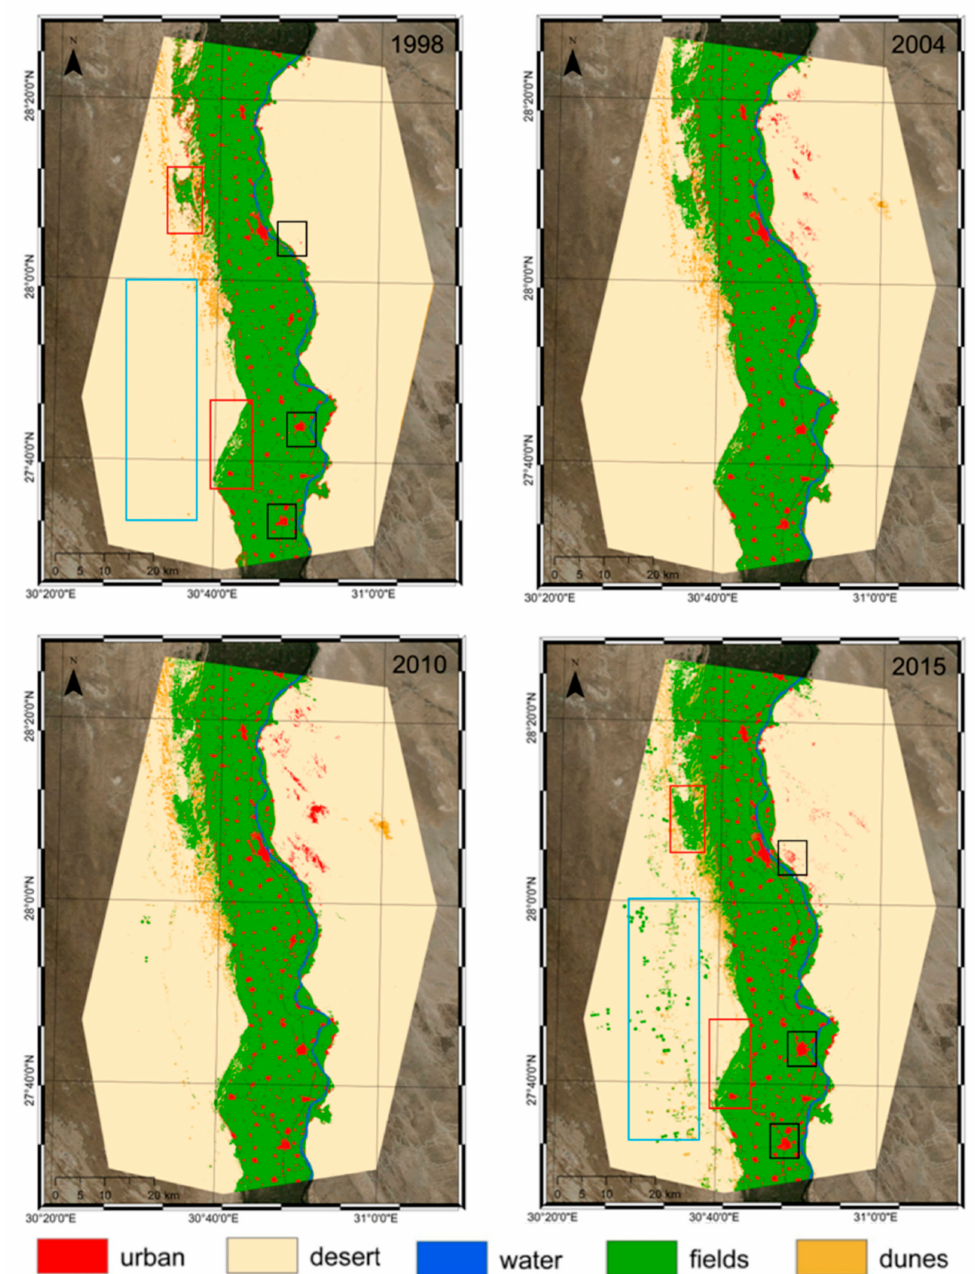
Figure 5. LULC maps obtained over the study area with a data fusion approach using SAR and multi-spectral data for 1998 and 2015. Black rectangles highlight areas with an urban increase, cyan rectangles correspond with fields increase in the desert area and red rectangles with crop increase within the Nile Valley and interaction